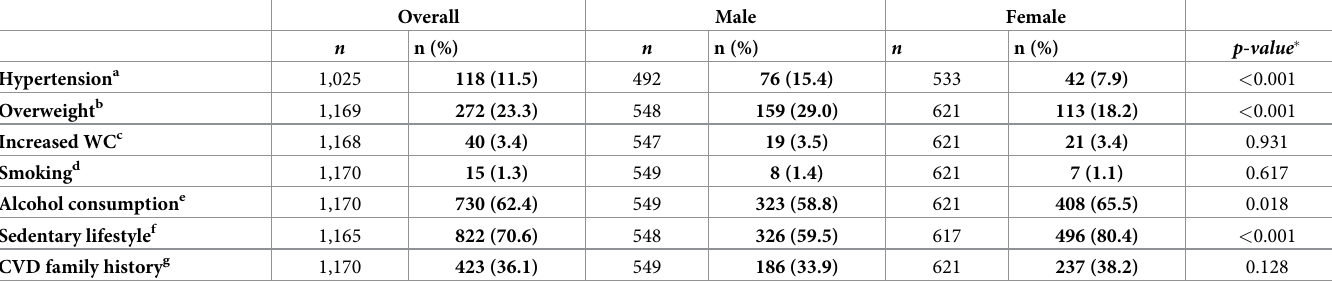
Table 2. Prevalence of cardiovascular risk factors in the overall study population and stratified by sex.